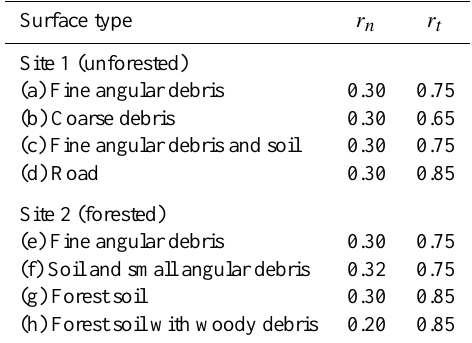
Table 1. Coefficients of restitution ( r n = normal, r t = tangential coefficient) used in the simulation series for the Vaujany